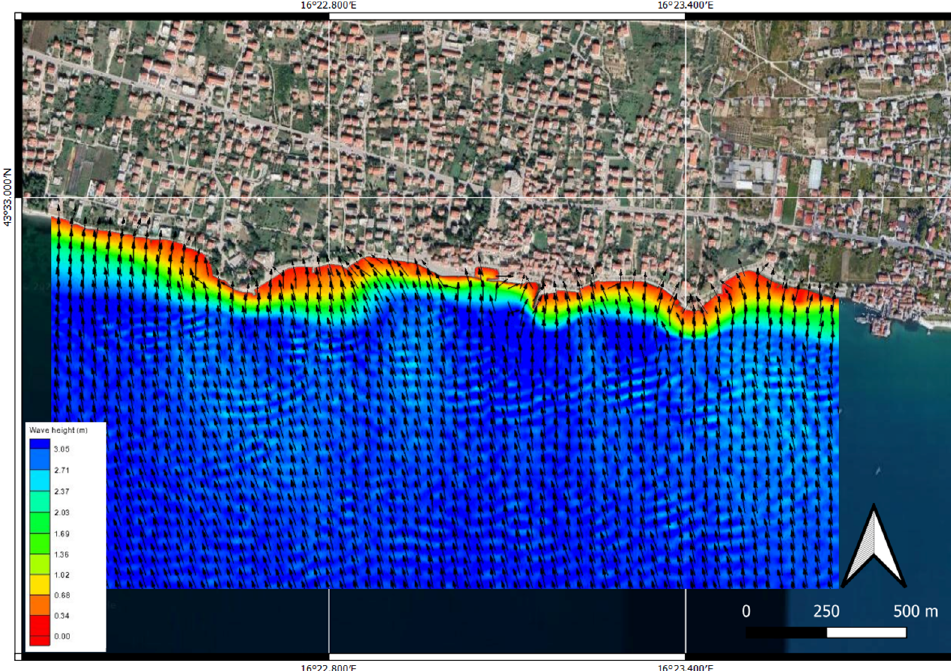
Figure 11. Wave heights and directions for the SE incident direction—local study area.